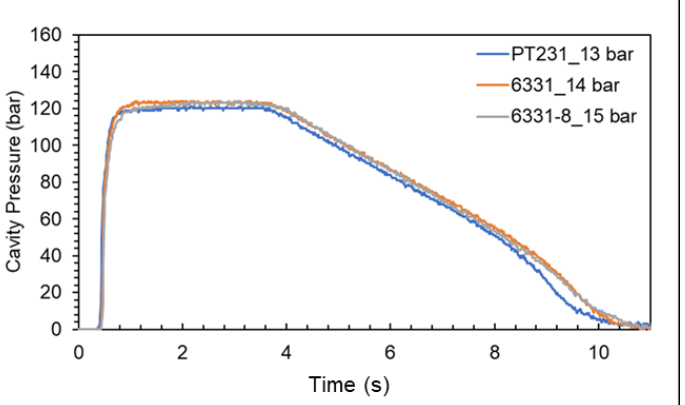
Figure 22. The cavity pressure profile of three materials with different viscosities at appropriate packing pressure.